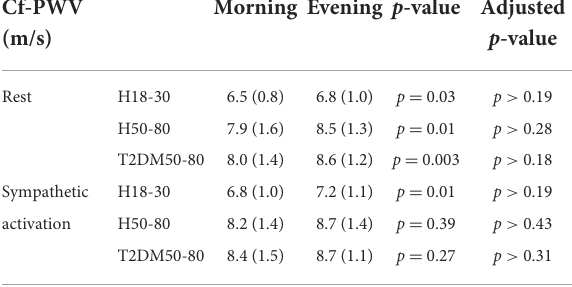
TABLE 2 Circadian changes in cf-PWV at rest and during sympathetic activation within each